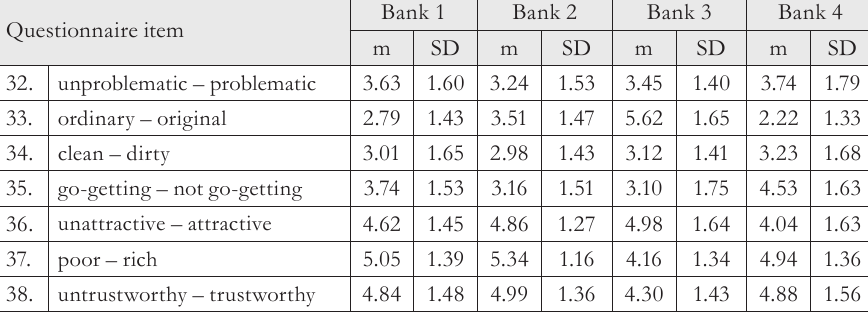
Tab. 3 - Average scores (m) and standard deviations (SD) of individual items in the semantic